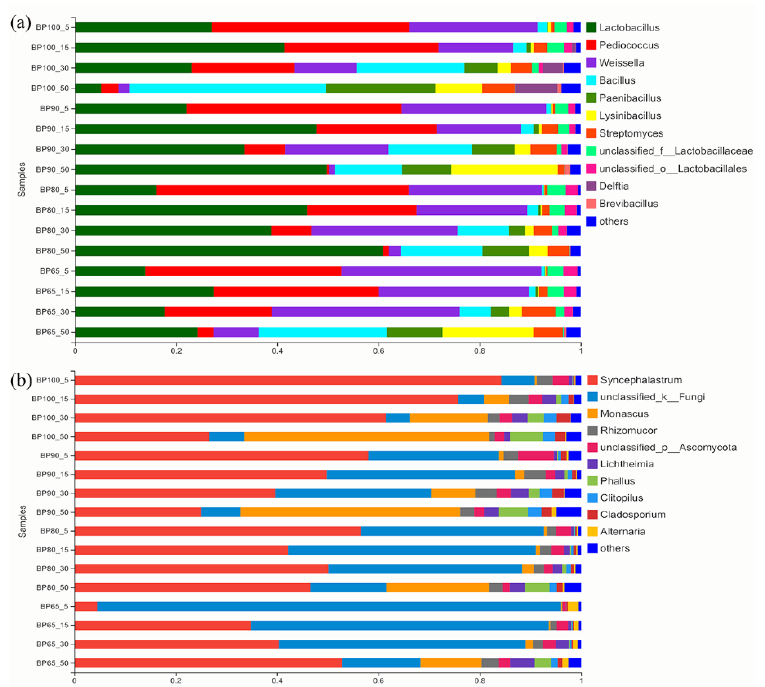
Figure 5. The relative abundances of bacterial ( a ) and fungal community ( b ) structure at genus levels.